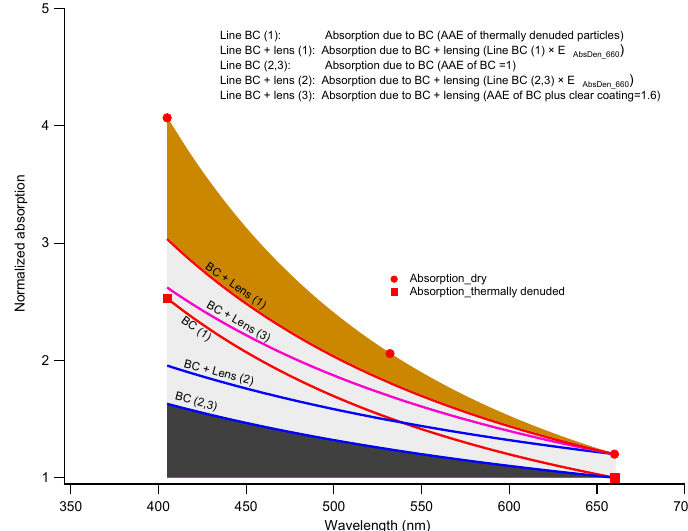
Figure 7. Conceptual representation of the three different approaches used to estimate the fraction of total absorption contributed by BC, BrC, and lensing. Numbers in parentheses correspond to the approach represented by that line. The y axis is normalized so that the denuded absorption of the 660nm channel is